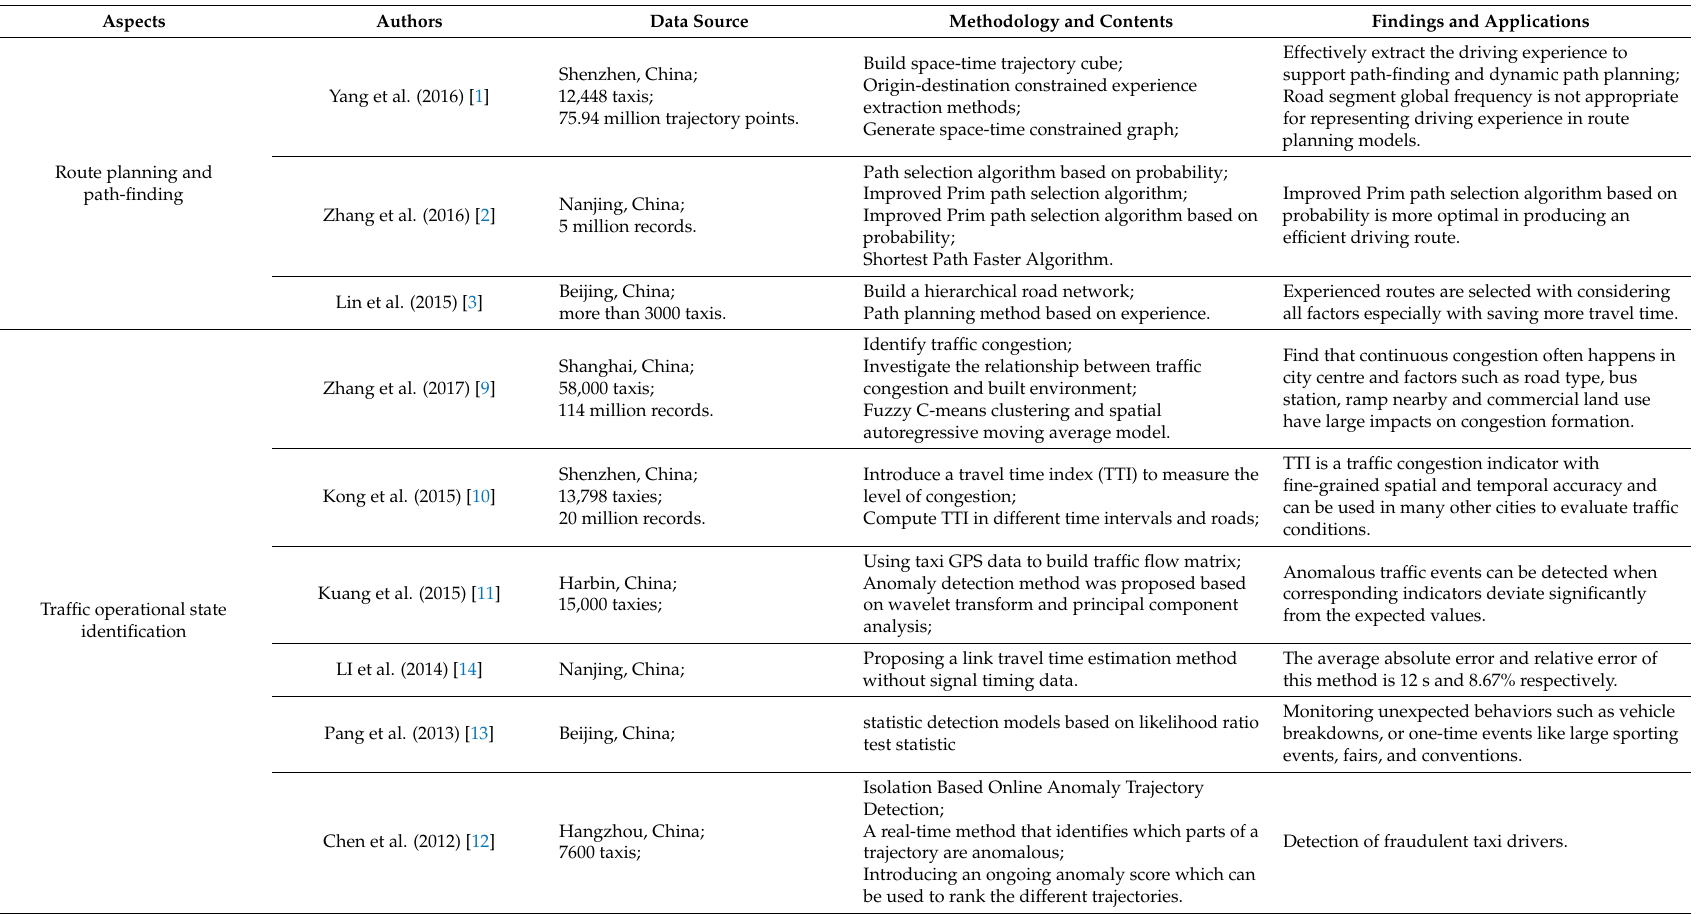
Table 1. Summary of current typical